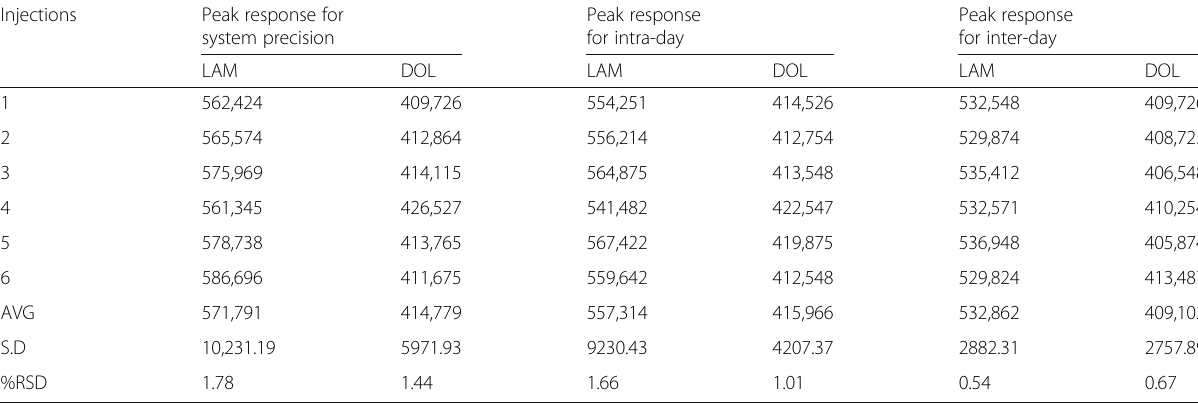
Table 4 System precision, intra-day and inter-day results for the developed method